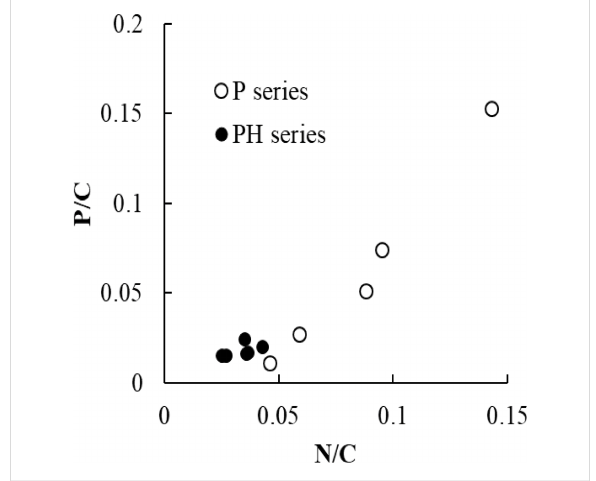
Figure 2: Correlations between P/C atomic ratio and N/C atomic ratio of P-series precursors (open circles) and HP-series carbon materials (closed